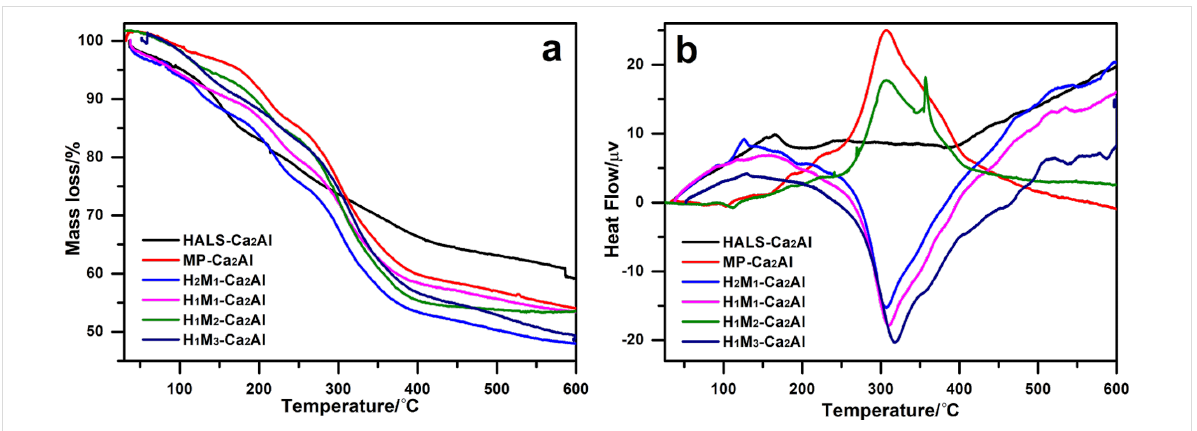
Figure 5: (a) TG and (b) DTA curves of Ca 2 Al-LDHs: HALS-Ca 2 Al, MP-Ca 2 Al, H 2 M 1 -Ca 2 Al, H 1 M 1 -Ca 2 Al, H 1 M 2 -Ca 2 Al, and H 1 M 3 -Ca 2